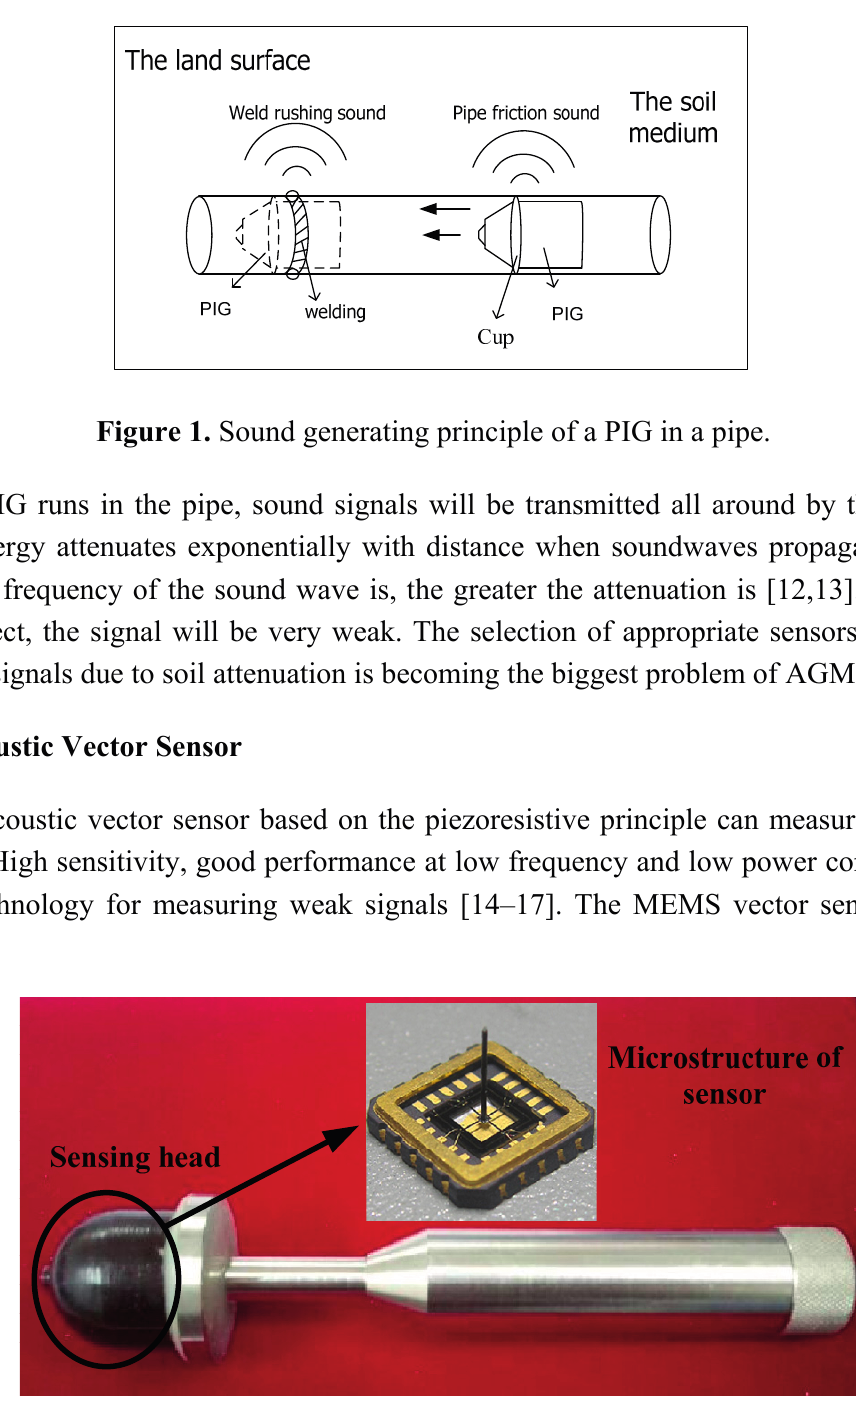
Figure 2. MEMS acoustic vector